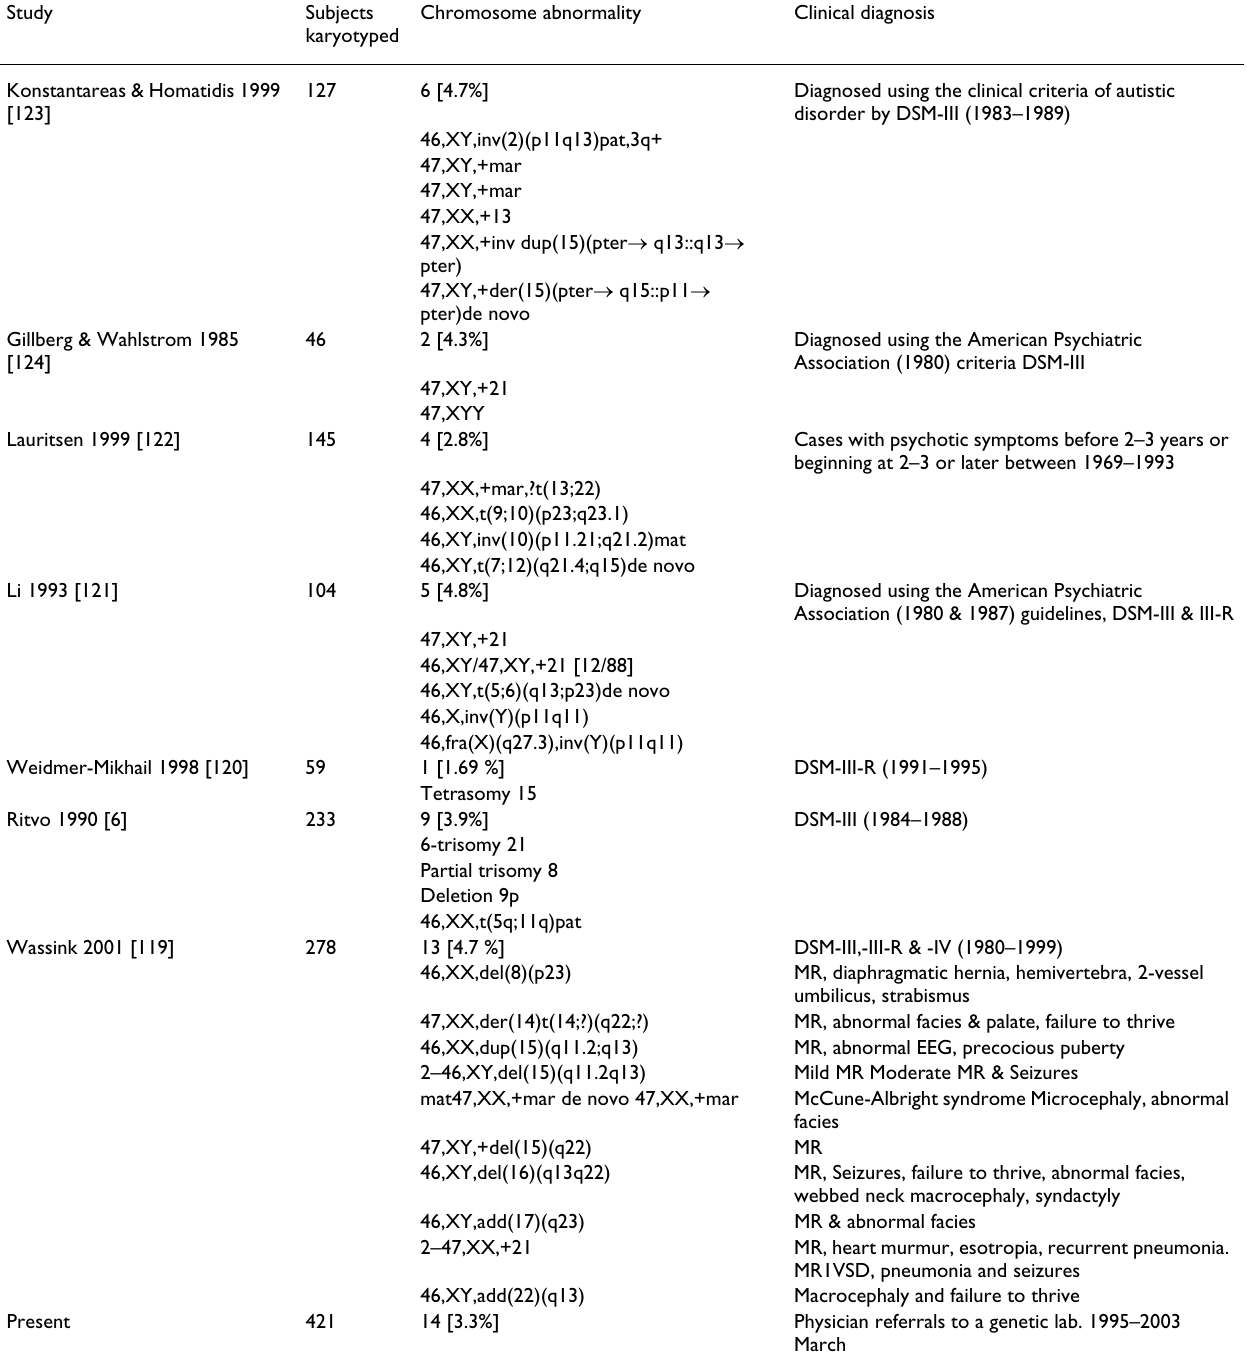
Table 5: Summary of reported population studies to assess the frequency of chromosome abnormalities (excluding fragile sites, polymorphisms and single cell abnormalities) Study Subjects Chromosome abnormality Clinical karyotyped